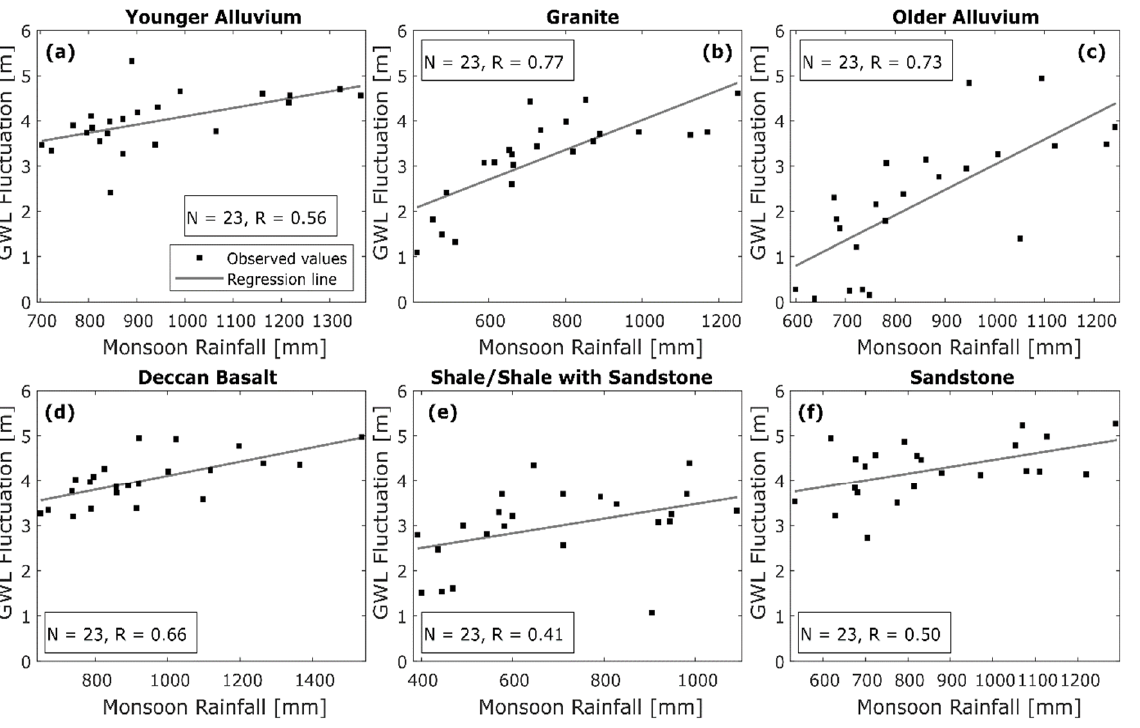
Figure 11. Comparison of average GWL fluctuation and monsoon rainfall from 1996 to 2018 ( n = 23) in the ( a ) Younger Alluvium, ( b ) Granite (banded gneiss complex), ( c ) Older Alluvium, ( d ) Deccan Basalt, ( e ) Shale/Shale with sandstone, ( f ) Sandstone aquifers, respectively.